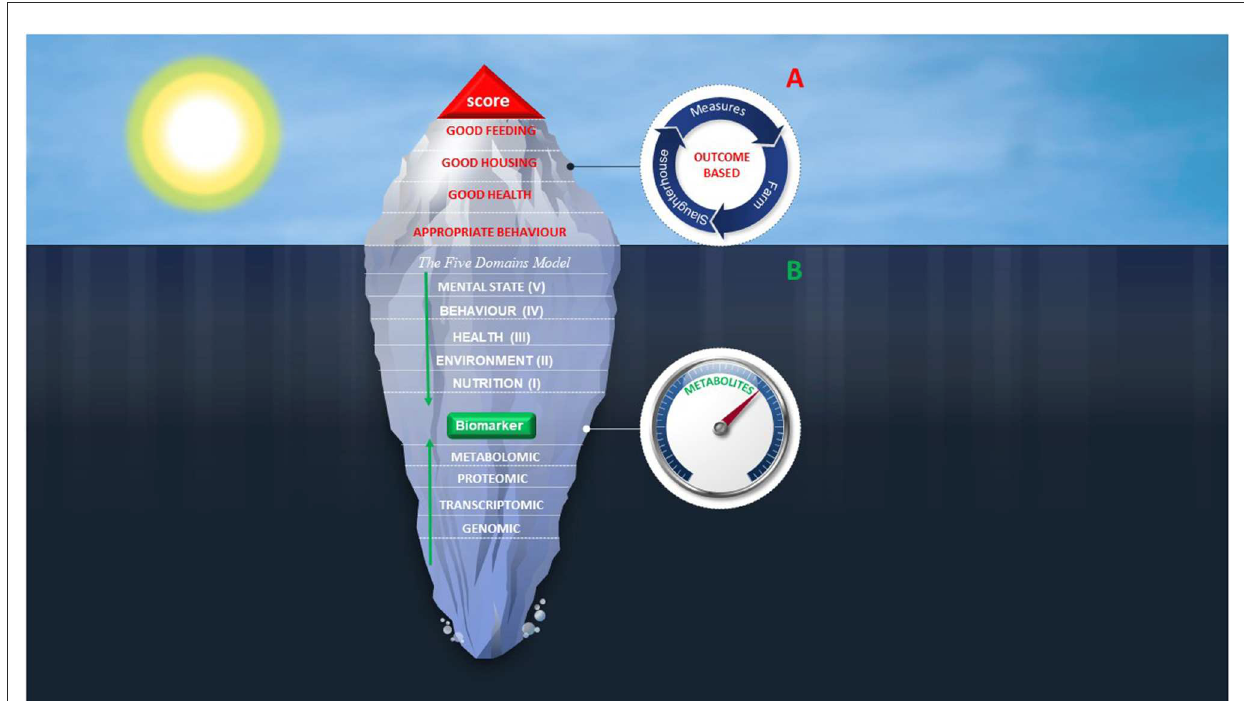
FIGURE2 Iceberg represents the proposal of a model for the future AW assessment. Combining scoring systems (A) with metabolites identification and quantification (B) may greatly improve the understanding of welfare condition and assessment. (A) Tip of the iceberg represents the current AW assessment protocols focused on management-based requirements and animal-based measures. Red items are welfare criteria on which are based measures on farm or at the slaughterhouse. These protocols provide a score indicating if welfare criteria are fulfilled. (B) Underwater part of the iceberg represents a new path for AW assessment that includes an integrated view of the Five Domains model. All Domains can affect the phenotypic outcome of living organism which can be explored through the metabolomics approach. The Five Domains model meets untargeted metabolomics in the molecules